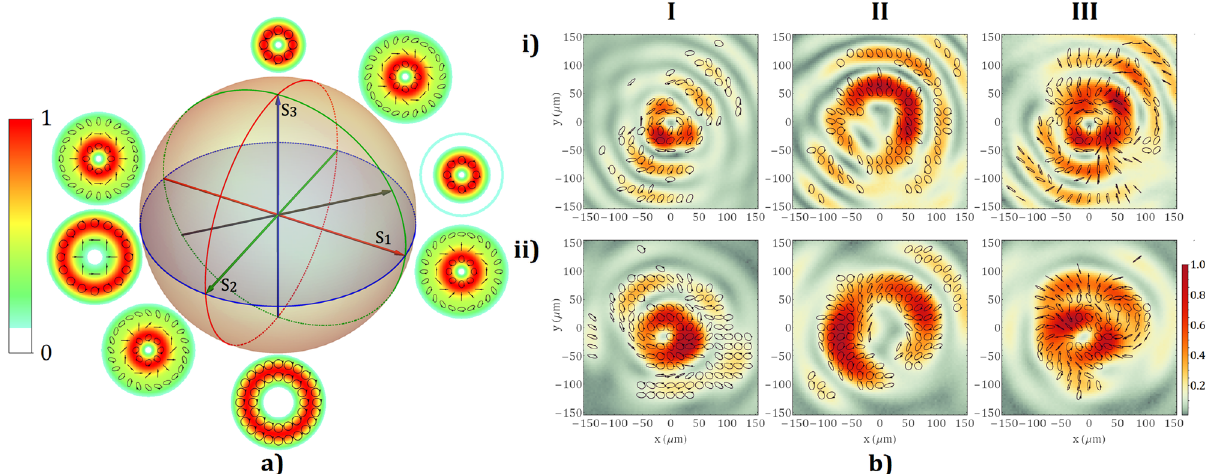
Figure 4. ( a ) Theoretical intensity and polarization distributions in the transverse plane for HVBs with m = − 1 and 3 represented on the Poincaré sphere. ( b ) The experimental polarization state and the intensity distribution of the scalar vector beams (I) m = − 1, (II) m = 3 and (III) their mixture obtained with the (i) oscillator and the (ii) high-power laser system.